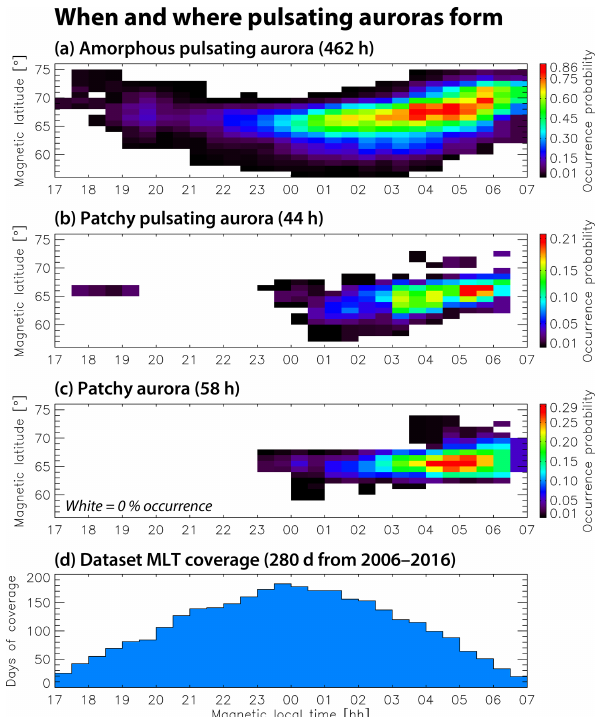
Figure 4. Occurrence probability of pulsating auroras based on a survey of times when Rankin Inlet, Gillam, and Pinawa THEMIS ASI had good visibility between 2006 through 2016. White bins in panels (a) , (b) , and (c) have data coverage but no events, corre- sponding to a 0% occurrence probability. Panel (d) shows the num- ber of days of data that had clear visibility in each MLT bin and coverage is uniform across the MLAT